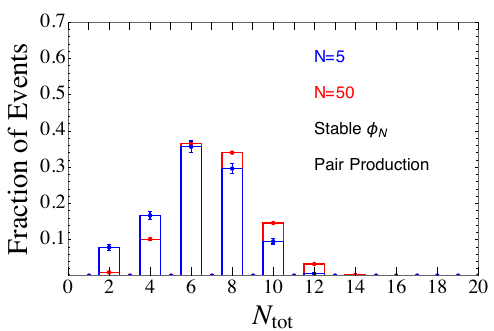
Figure 11. Comparison between 5 states and 50 states with the same average mass splitting. We show the total number of particles in the event for the Z in eqs. (3.1) and (3.2). Final state particles include two stable scalars.